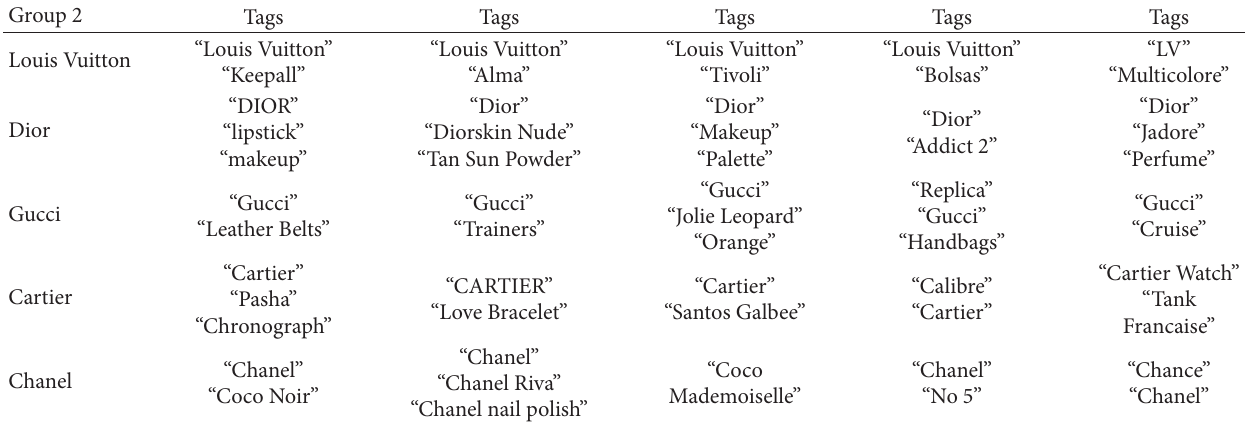
Table 3: The selected tags of group 2 from Flickr. Tags Tags